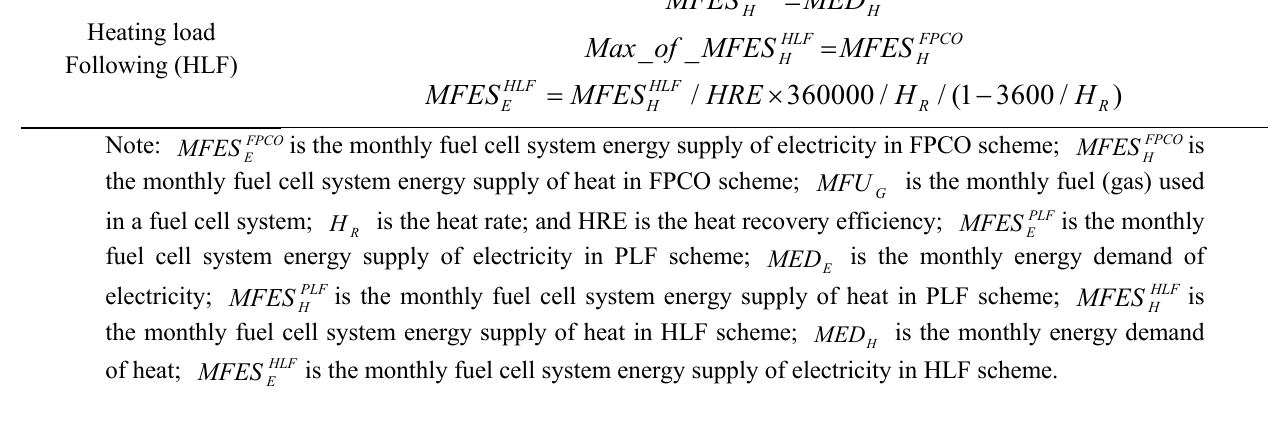
Table A2. Boundary condition of LCC and LCCO